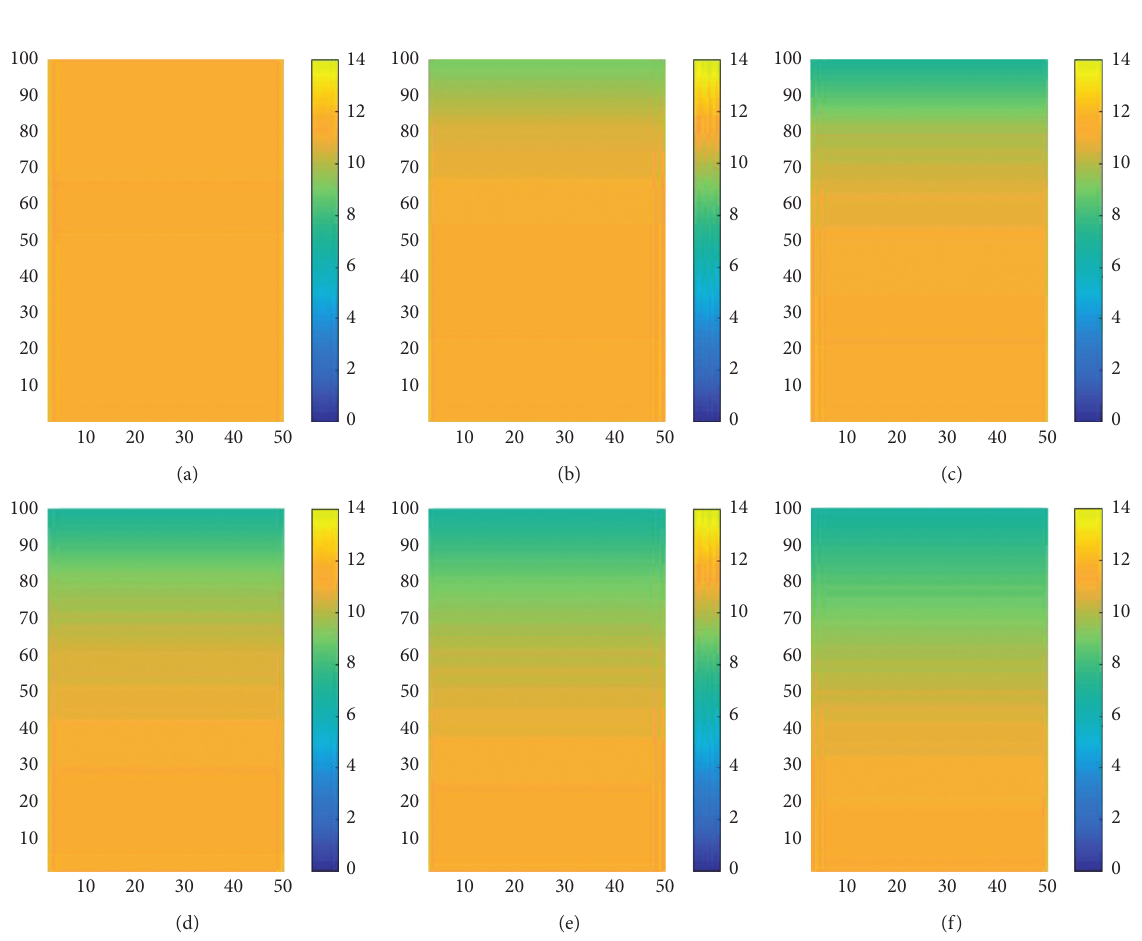
Figure 11: Evolution of carbonation extent of lime-stabilized expansive soil (using MATLAB). (a) Carbonation time-0d. (b) Carbonation time-1d. (c) Carbonation time-2d. (d) Carbonation time-3d. (e) Carbonation time-4d. (f) Carbonation